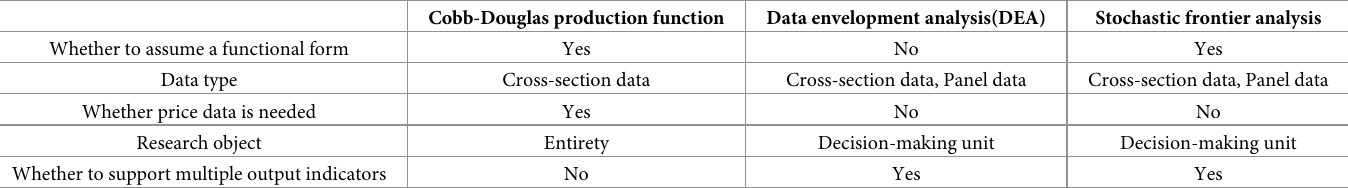
Table 5. Comparison of different methods for estimating the total factor